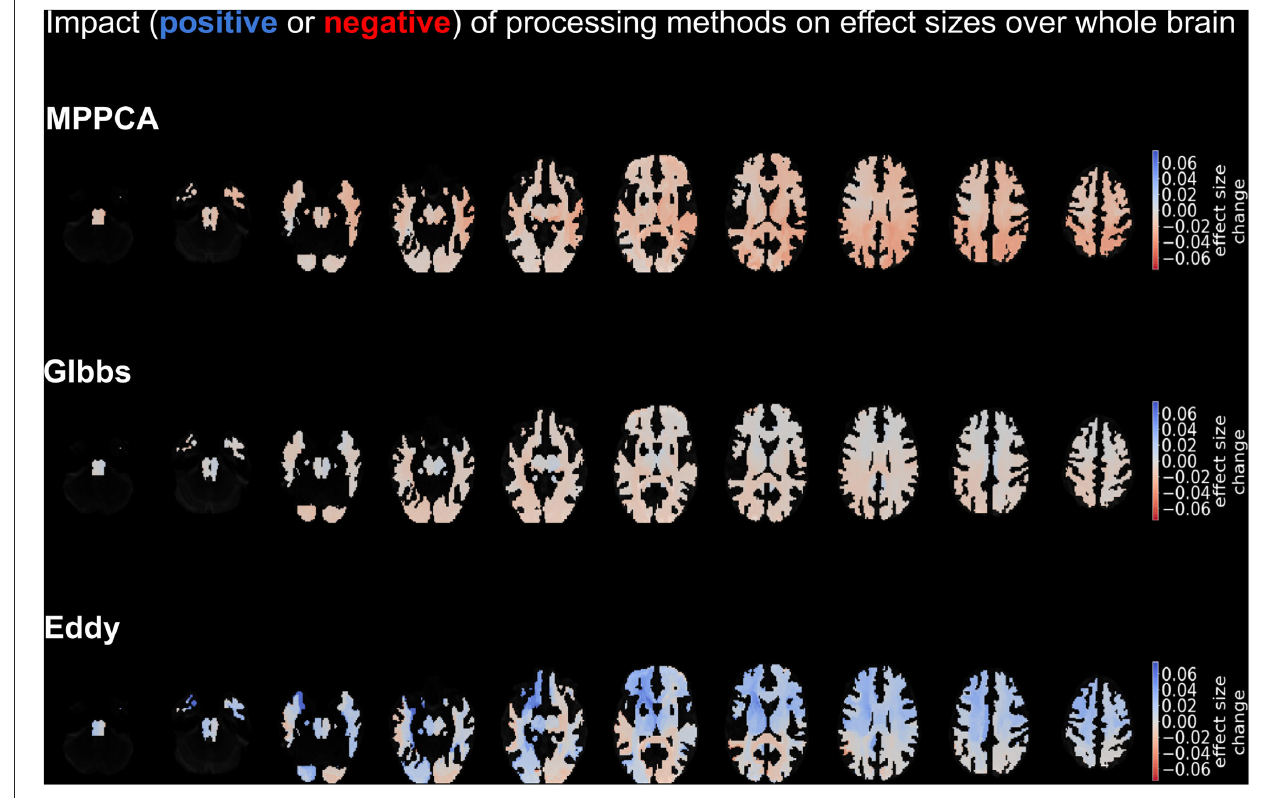
FIGURE 6 | Depiction of the impact on effect sizes of each processing method. Impact is demonstrated in shades of blue (positive impact) and red (negative impact), with the former colors denoting an increase in effect size on that tract due to the method and the latter a decrease in effect size due to the method. The top panel refers to the impact of MPPCA method, the middle panel to the impact of Gibbs method, and the bottom panel to the impact of Eddy method. The depicted results were obtained by averaging over the mean diffusion tensor and kurtosis parameters, as well as the acquisition